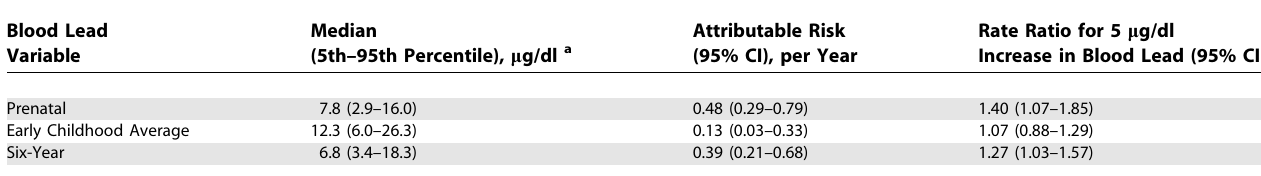
Table 2. Relationship of Prenatal, Early Childhood Average, and Six-Year Blood Lead Concentrations with Total Arrest Rates in Young Adults Blood Lead